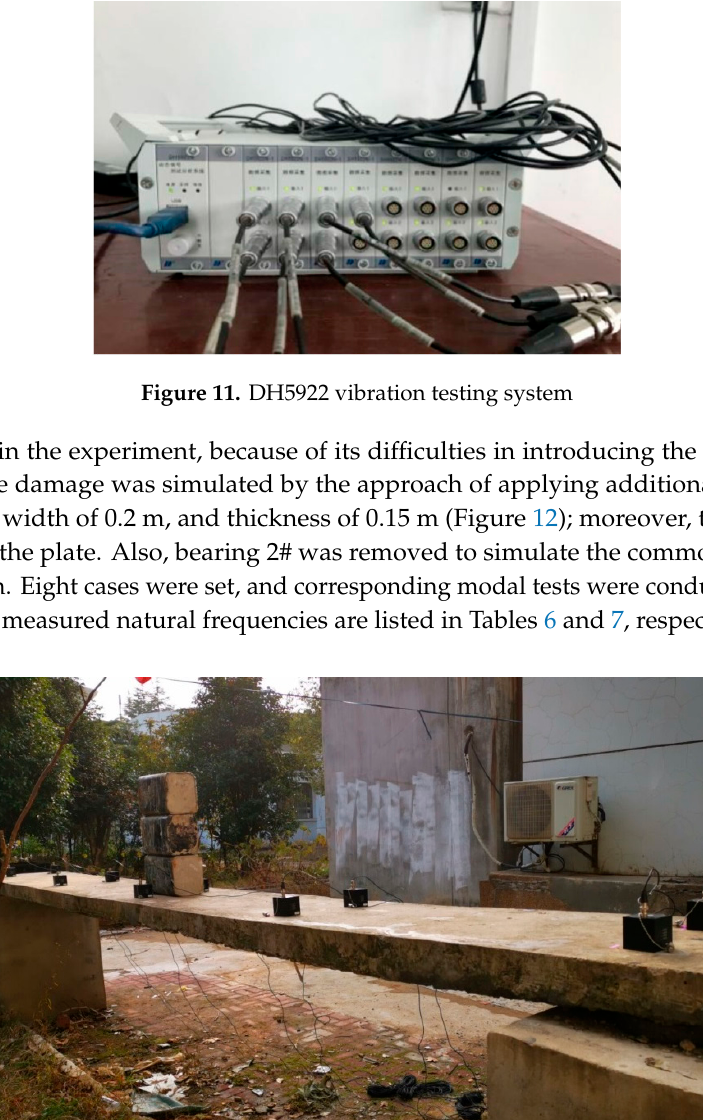
Figure 10. The simply supported reinforced concrete plate: ( a ) view of modal test; ( b ) layout of sensors and mass block.